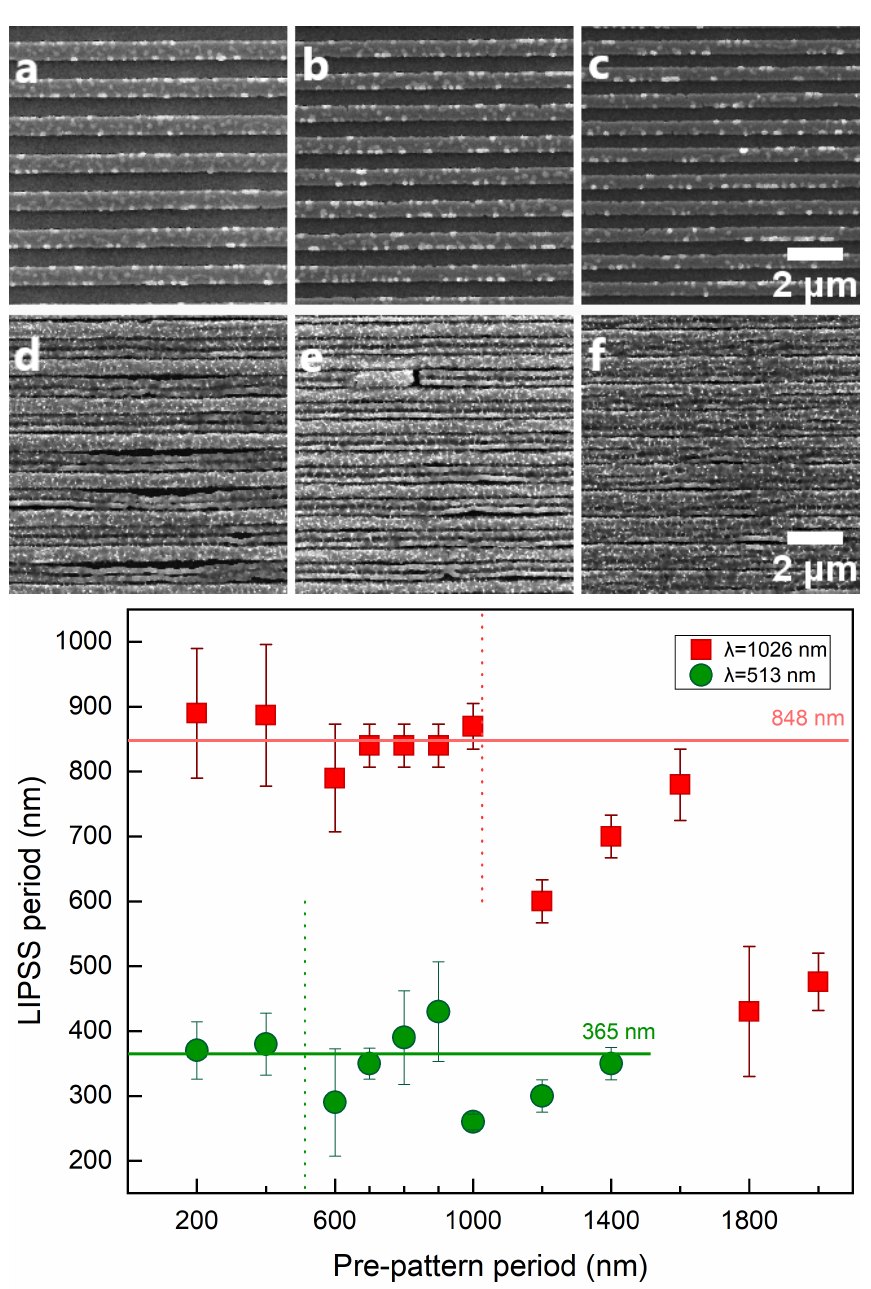
Figure 4. LIPSS on Nickel surfaces with different pre-pattern periodicities and a pre-pattern ori- entation perpendicular to the laser polarization. The SEM micrographs represent a comparison of non-irradiated pre-pattern structures ( a – c ) with periods 1400, 1200 and 1000 nm, respectively, and laser-induced ripples on the same pre-pattern structures with LIPSS period 350, 300 and 250 nm, re- spectively ( d – f ). The upper row ( a – c ) show the pre-pattern period and orientation. Laser parameters are the same for d, e and f. Femtosecond laser pulses with 513nm laser wavelength, 25 laser pulses per spot and peak fluence at 0.12J/cm 2 Irradiation with IR (filled squares) and visible (filled dots) fs laser pulses, with laser polarization perpendicular to the pre-pattern orientation. The vertical dotted lines represent the size of the laser wavelength. The horizontal lines correspond to the average LIPSS period when laser polarization is parallel to the pre-structures (see Figure 3). Here, LIPSS spatial period is independent of the pre-pattern spacing when the spacing is equal to or smaller than the laser wavelength. In contrast, at higher pre-pattern spacing, the pre-pattern has a great impact on the final LIPSS